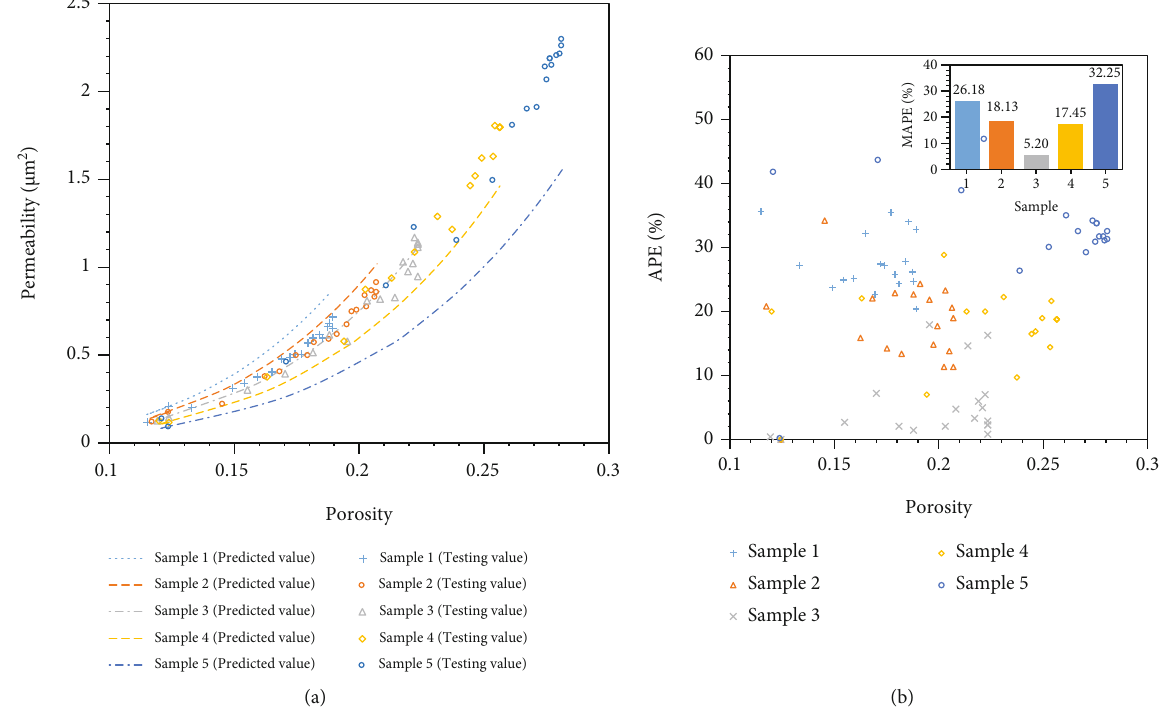
Figure 10: Comparison between testing results and predicted results by Carman-Kozeny model (a). Comparison of results (b) APE and